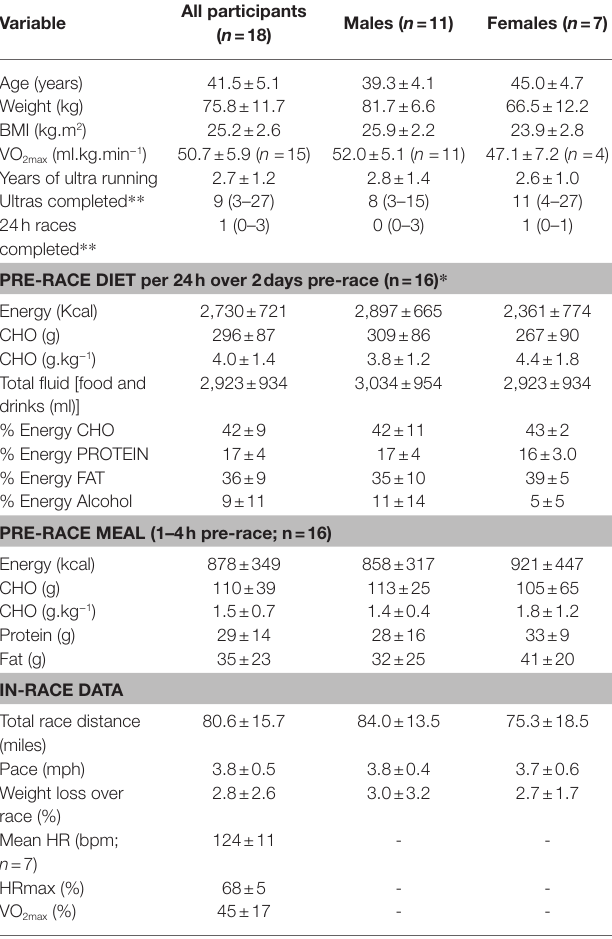
TABLE 1 | Participant anthropometric data, VO 2max , ultra-endurance running experience and nutritional composition of the pre-race diet, pre-race meal prior to the start of a 24-h ultra-endurance race, and in-race data (distance covered, pace, mass loss, heart rate, and relative %HR max and %VO 2max ) by n = 18 participants during the Glenmore 24 trail